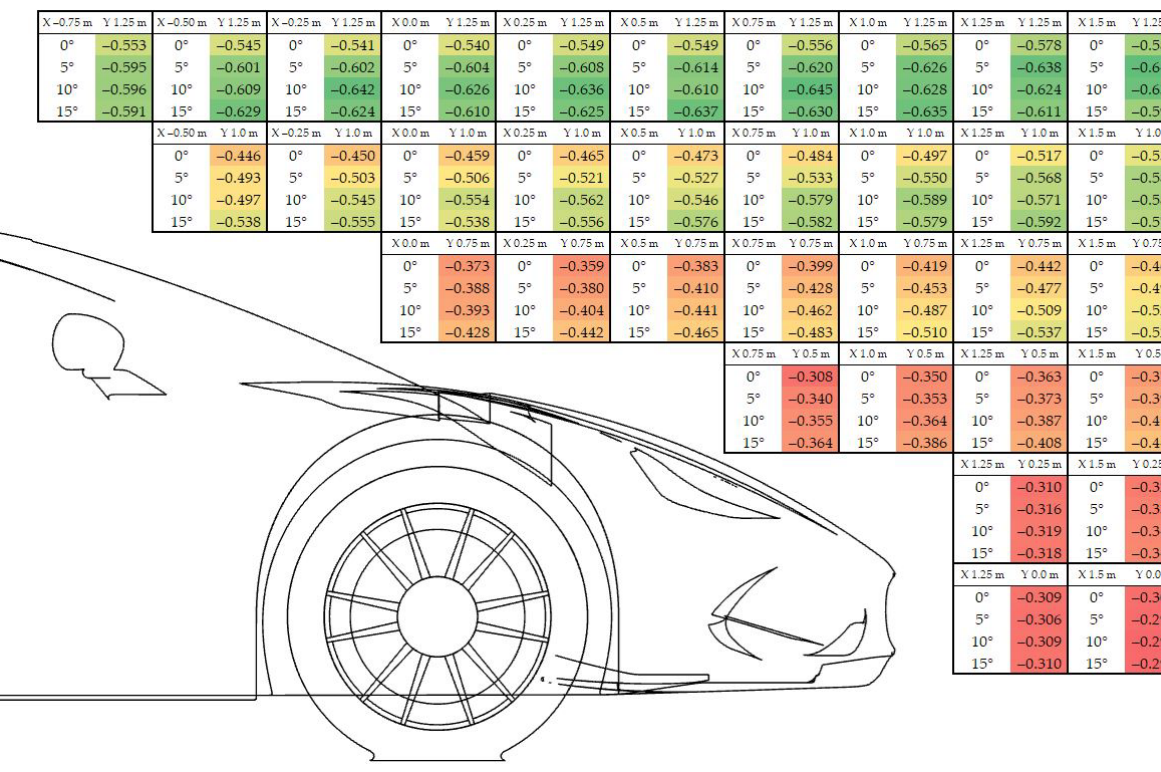
Figure 18. Lift coefficient for various positions and angles of attack of the front wing.